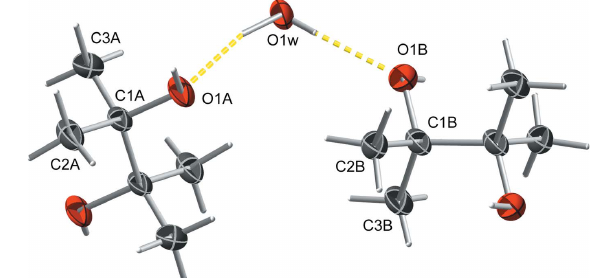
Figure 10 An ellipsoid plot (50% probability) of SAXDUR, generated using ShelXle (Hu¨bschle et al. , 2011). The simplicity of the molecule belies the complexity of the twinning.